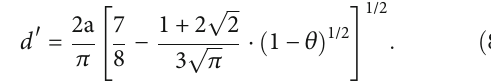
Figure 3: Unit cell orthographic projection.